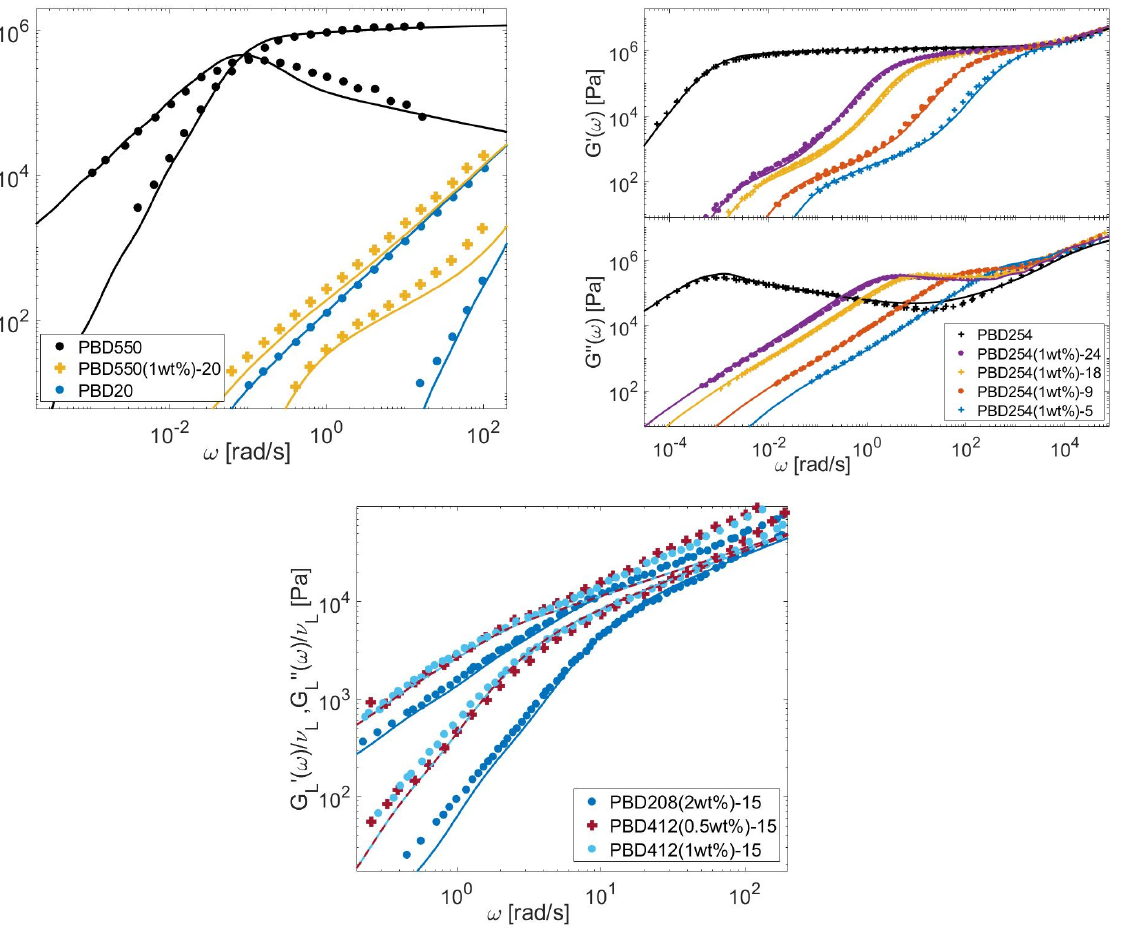
Figure 16. Comparison between predicted (continuous lines) and experimental (symbols) storage and loss moduli of the long PBD chains in monodisperse state or diluted in various matrices (see Tables 2, 5 and 6).